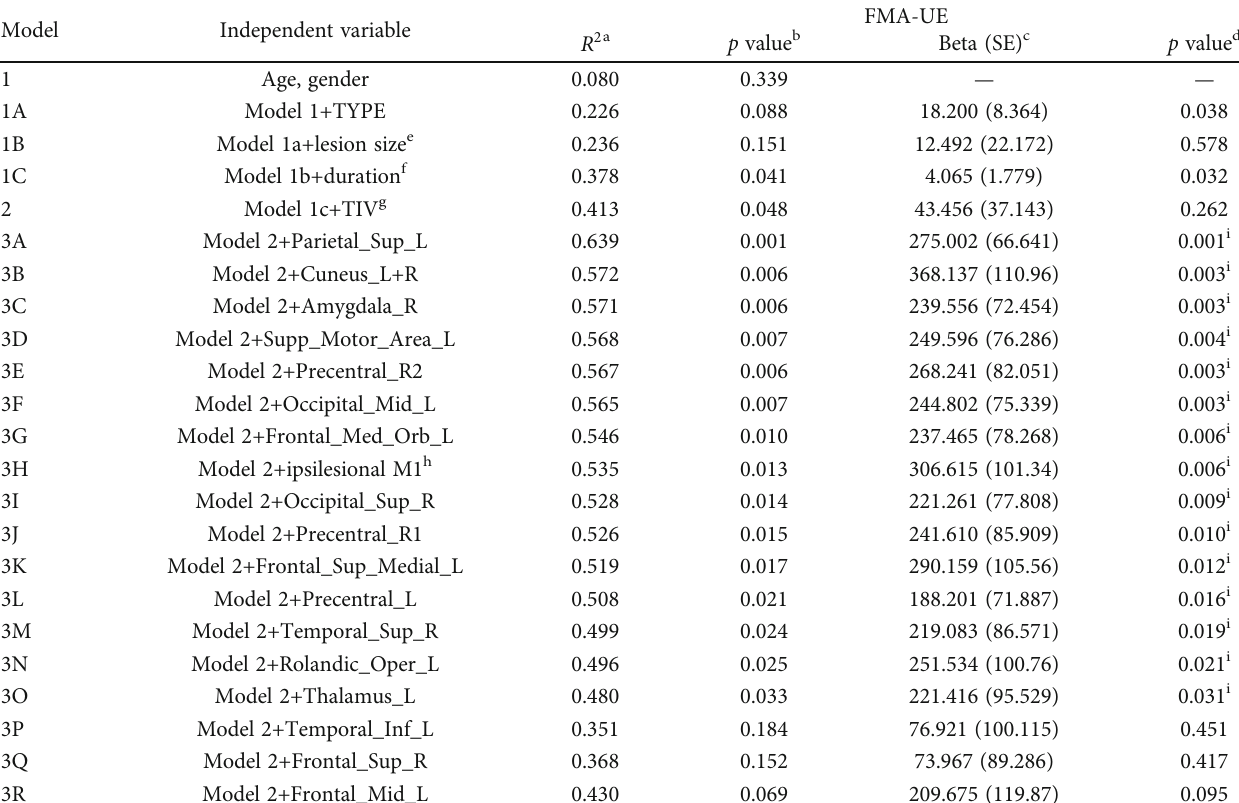
Table 5: Associations of regional GM volume with motor function in right-sided stroke patients.